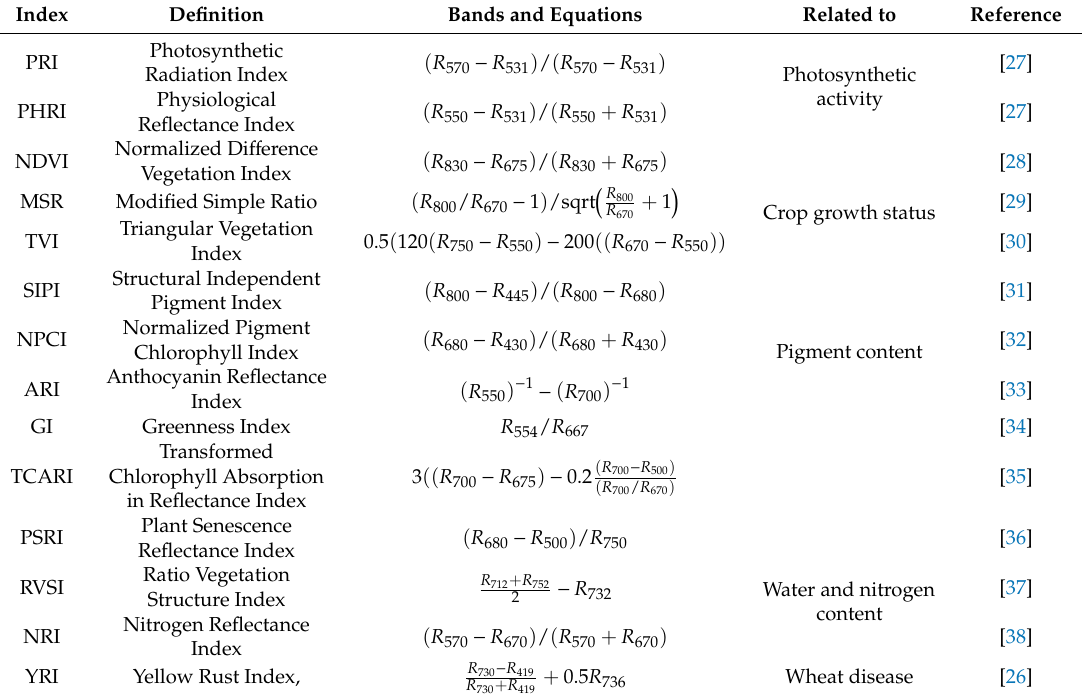
Table 2. Vegetation indices used for the identification of wheat yellow rust in this